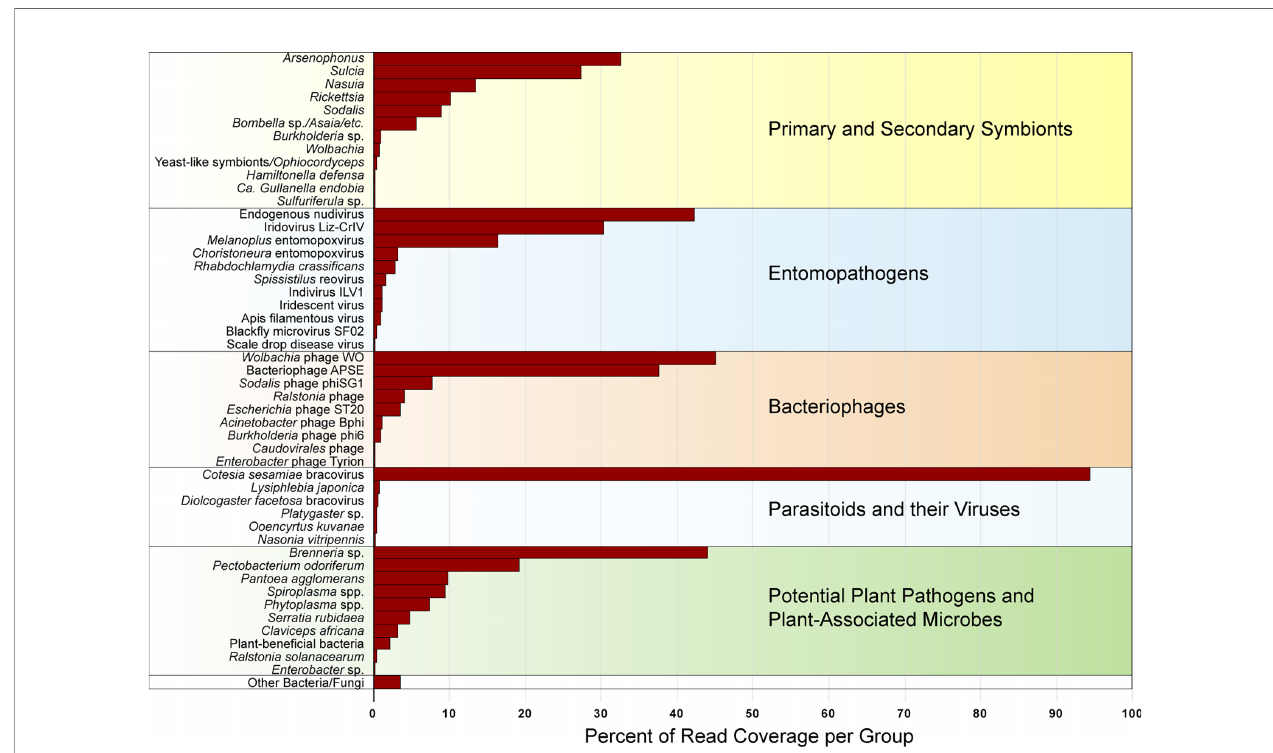
FIGURE 1 | Relative abundance of primary and secondary membracid symbionts, entomopathogens, bacteriophages, parasitoids and their viruses, and potential plant pathogens (classi fi ed based on predominant function of closest blast hit), combined for all membracids, expressed as percentage of read coverage per each group shown in the fi gure, after normalizing between samples based on membracid cytochrome oxidase I (COI) gene coverage, calculated as a percentage of the read coverage for assembly scaffolds with blast hits to 16S rRNA genes (for bacteria), 18S rRNA genes (for fungi), or genomes for viruses and mycoplasmas or